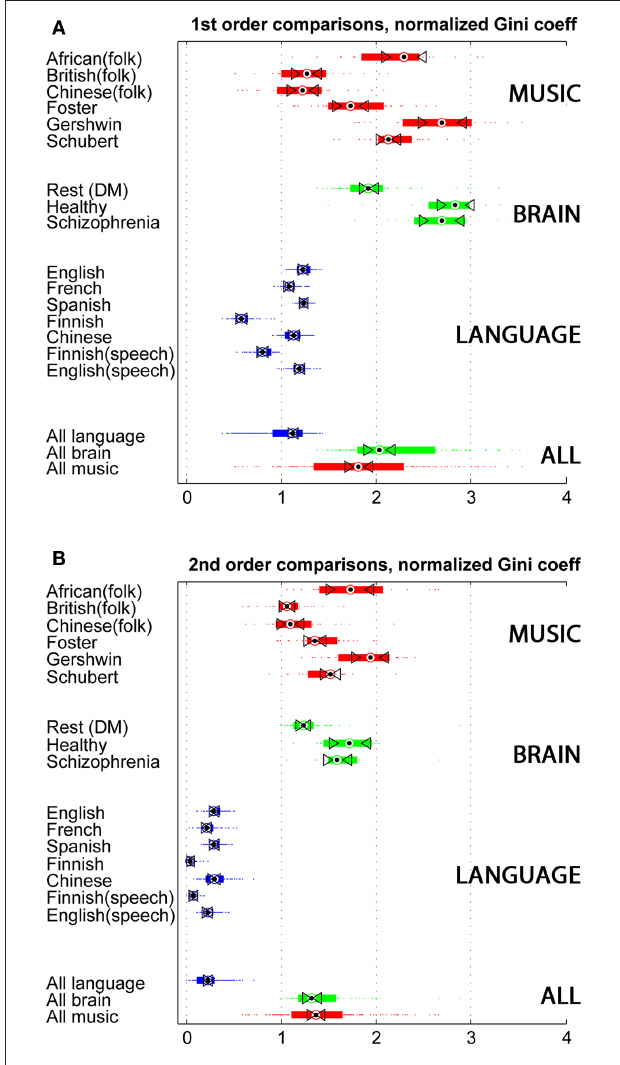
FIguRe 3 | Three-way comparison of music, language, and fMRI data. The figure scheme is as in Figure 2 . Green bars represent data from 99 subjects in three experiments. Healthy and Schizophrenia subjects both performed an “auditory oddball task,” consisting of identifying a target tone in a stream on non-target tones and distracting noises. The largest group comprises 64 subjects in the rest condition (also known as Default Mode). (A) 1st order sparseness, i.e., sparsity/density of single symbols. (B) 2nd order sparseness, i.e., sparsity/density of sequential pairs of